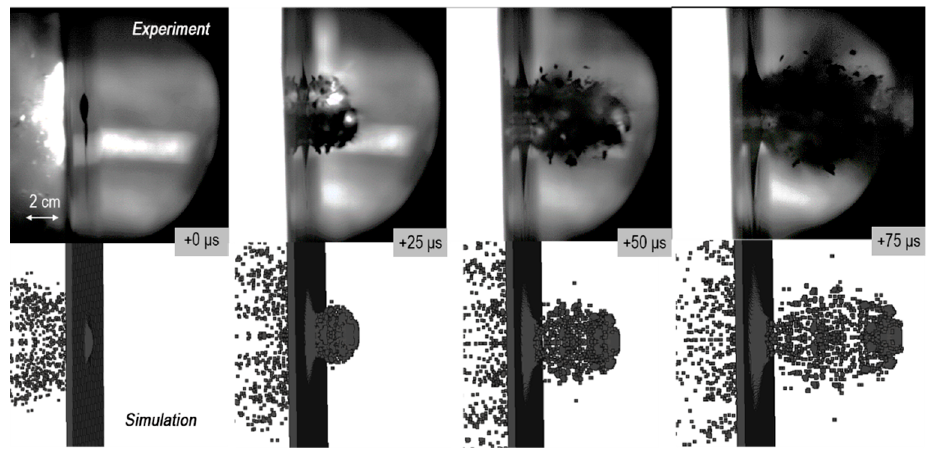
Figure 10. The debris cloud shape of Bumper II of Configuration B-1 by the experiment and the simulation.